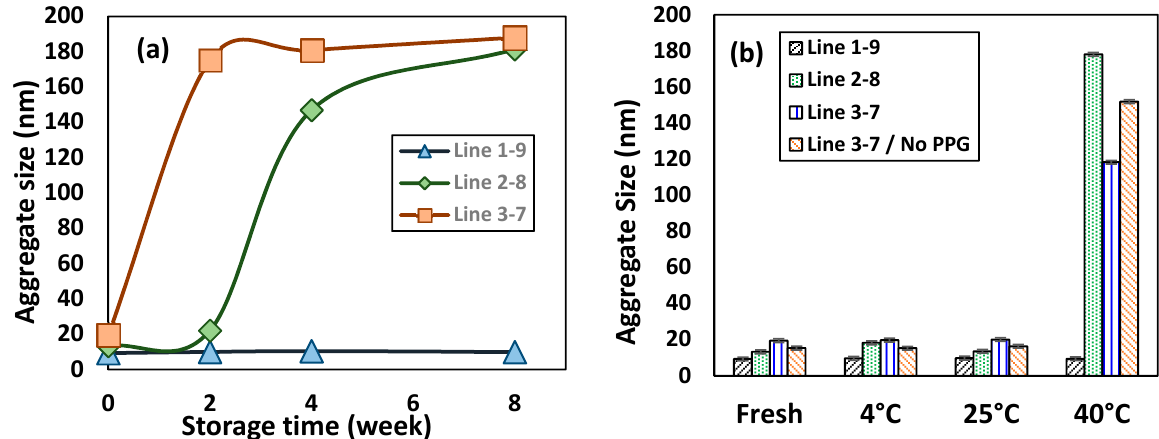
Figure 3. Effect of storage temperature and time on the aggregate size of microemulsion prepare from mixed surfactants of Triton CG-110/PPG (1.8:1 w / w ) and 1 wt% in-house hydrodistilled TTO: ( a ) Stored at 25 °C, ( b ) Measured after one-week storage.